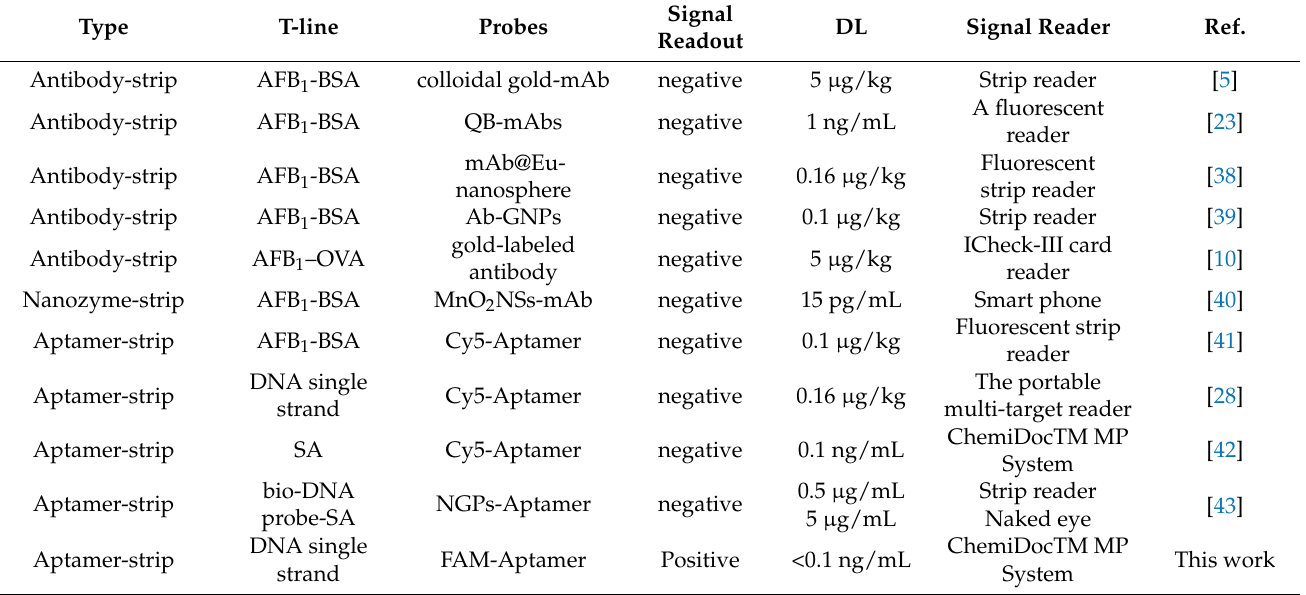
Figure 2. ( a ) Images of Apt-strips after the assay procedures. The numbers below the strips are the standard concentrations of AFB 1 (ng/mL). ( b ) Fluorescence intensity at the detection line of Apt- strips identified by image J. ( c ) The calibration curve for the quantitation of AFB 1 using fluorescence intensity versus the concentration of AFB 1 . Error bars are based on three duplicate measurements of different AFB 1 concentrations. Table 1. Comparison of the Apt-strip in this study with other methods for AFB 1 detection based on